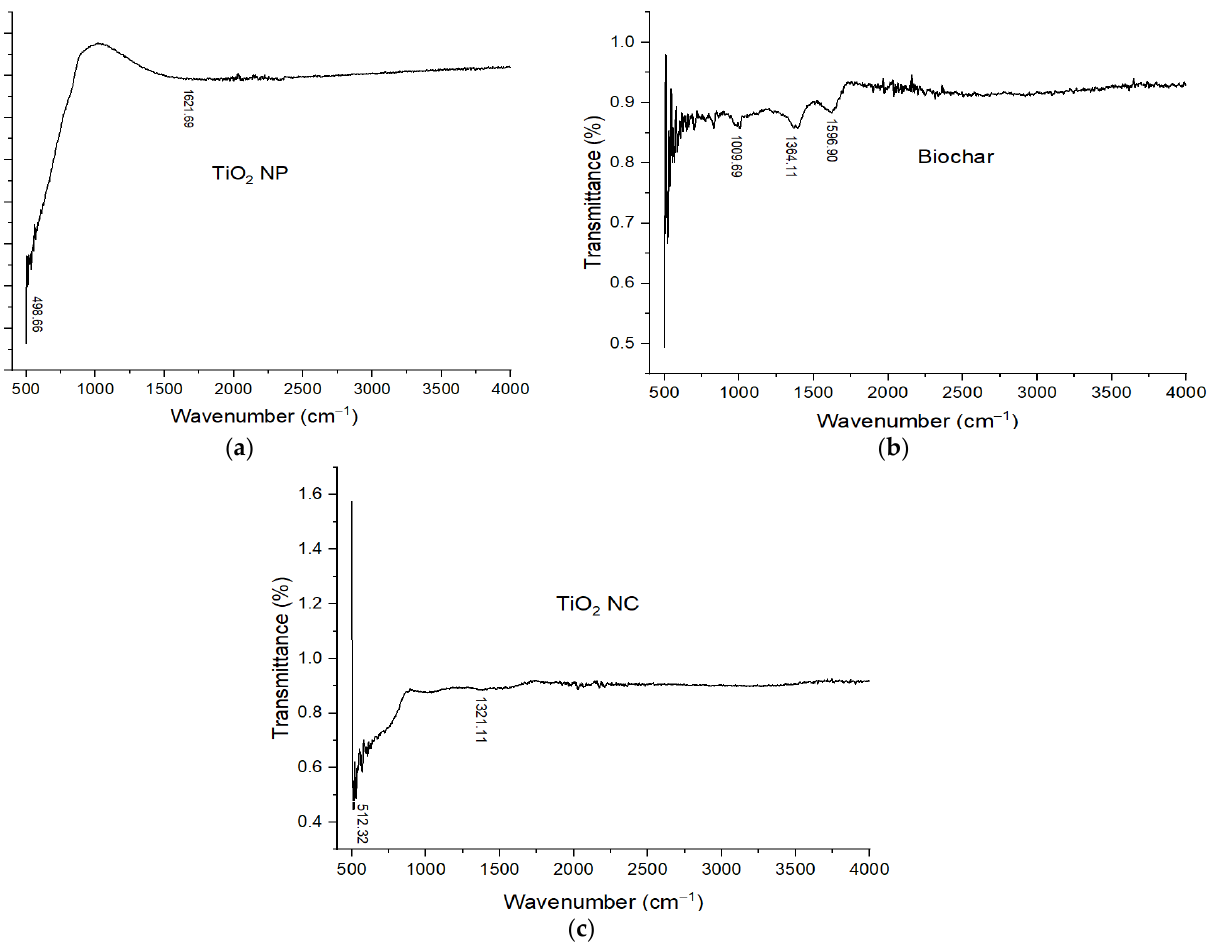
Figure 4. FT-IR spectra of ( a ) TiO 2 NP; ( b ) biochar; and ( c ) TiO 2 nanocomposite.